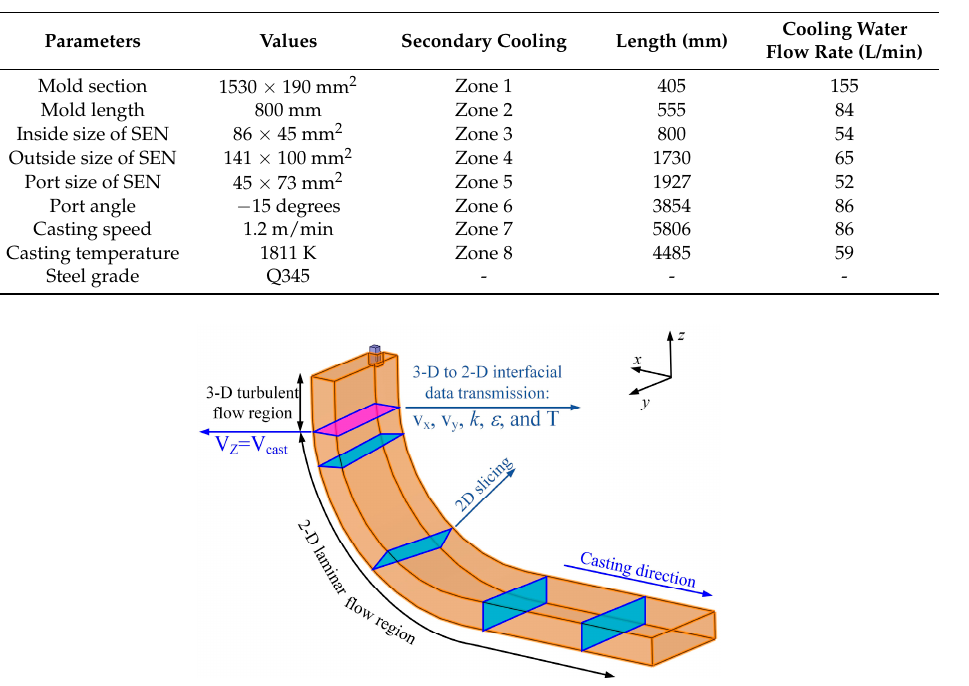
Figure 1. Illustration of 3-D turbulent flow and 2-D laminar flow regions during the CC (continuous casting) process.